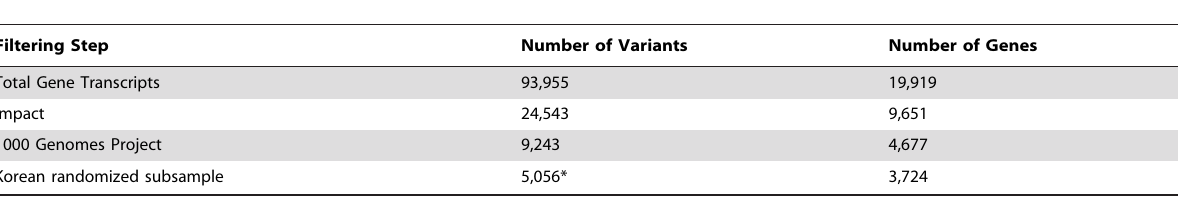
Table 1. Number of genes common to the 6 affected individuals in each filtering